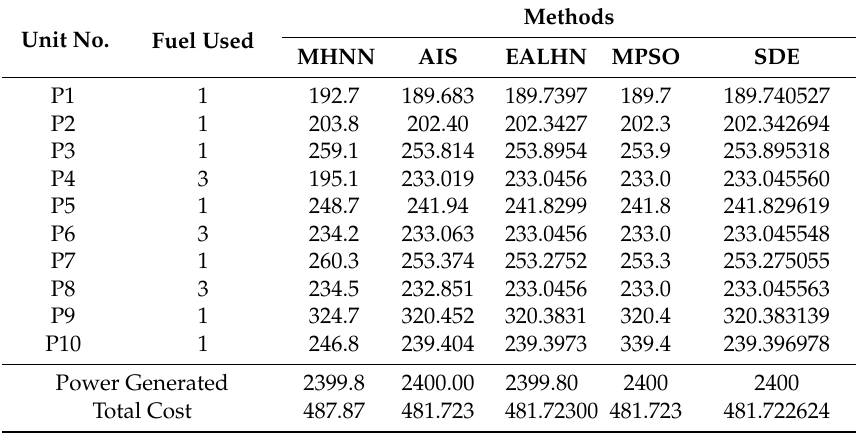
Table 4. Cost comparison among various methodologies for System 1, P d = 2400 MW.